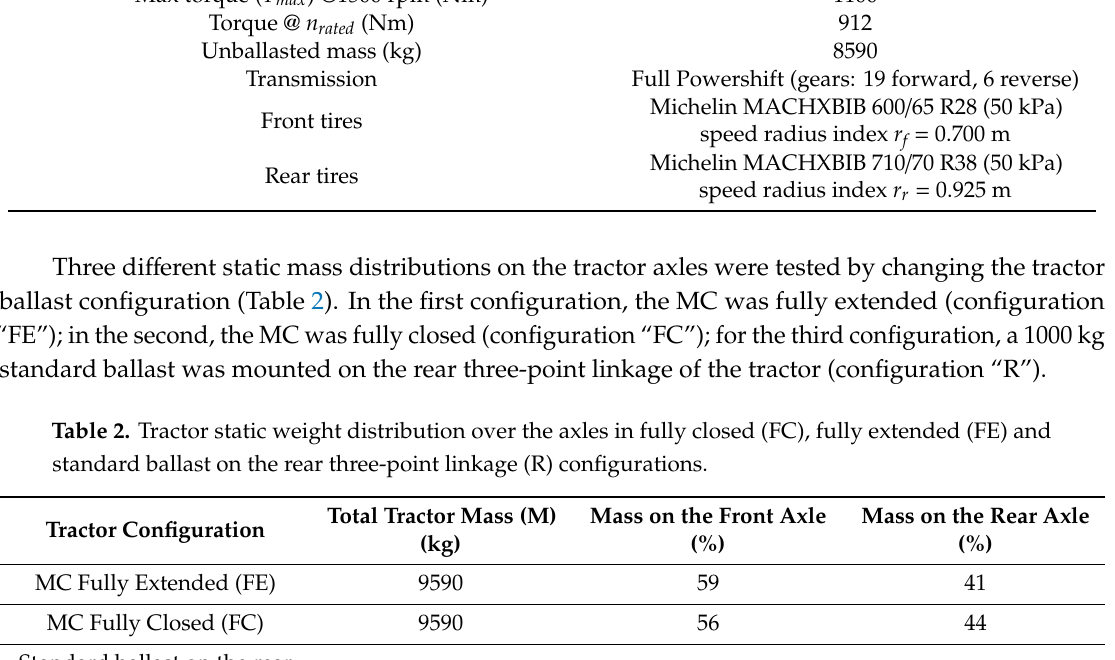
Table 2. Tractor static weight distribution over the axles in fully closed (FC), fully extended (FE) and standard ballast on the rear three-point linkage (R) configurations.